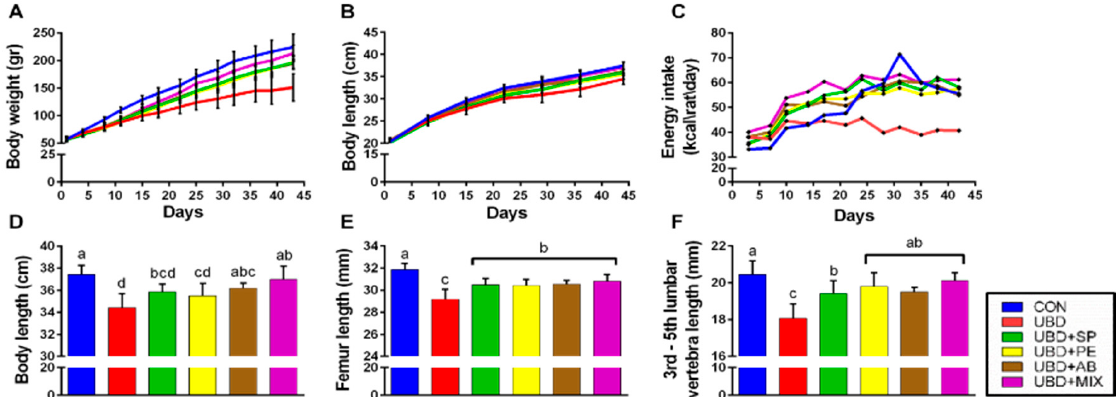
Figure 1. Growth patterns and food consumption. ( A ) Body weight during the entire experiment (gr). ( B ) Body length during the entire experiment (cm). ( C ) Energy intake (kcal/rat/day). ( D ) Body length in the end of the experiment (cm). ( E ) Femur length measured by micro-CT (mm). ( F ) 3rd–5th lumbar vertebra length measured by micro-CT (mm). Values are expressed as mean ± SD of n = 8 rats/group, different superscript letters are significantly different ( p < 0.05) by one-way ANOVA followed by Tukey’s test.